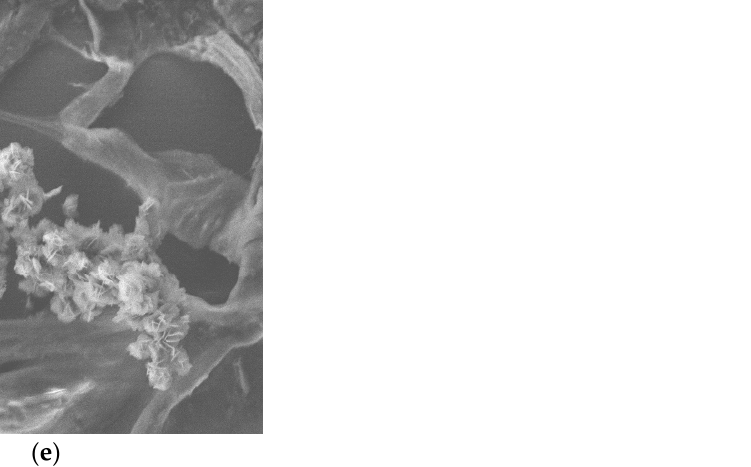
Figure 10. SEM images of the surface of the pristine MA-41P membrane ( a ), a scaling layer on its surface after about 5 h of electrodialysis processing of the artificial solution ( b ), and an enlarged image of the scaling morphology ( c ), as well as an image of the scaling on surface of the MA-41Pmod membrane ( d ) and enlarged image of the scaling morphology ( e ).